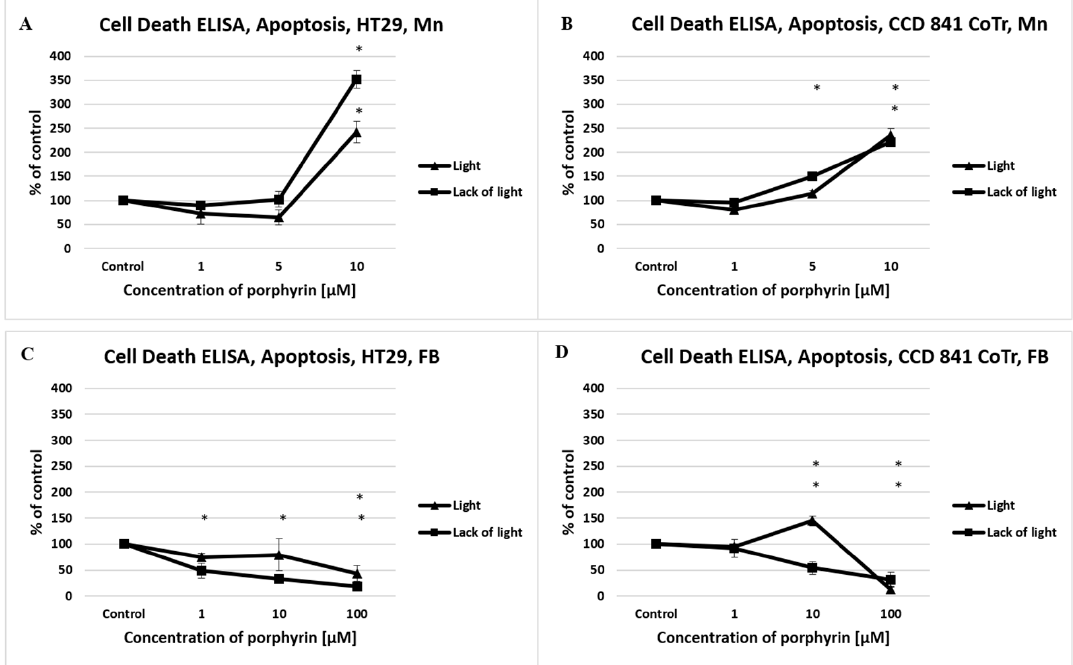
Figure 5. The level of apoptosis induced by manganese porphyrin (Mn) and free-base porphyrin (FB) analyzed by a Cell Death Detection ELISAPLUS assay. Columns and bars show the mean standard deviation ( n = 3). * - Statistical significance was analyzed at p < 0.05.